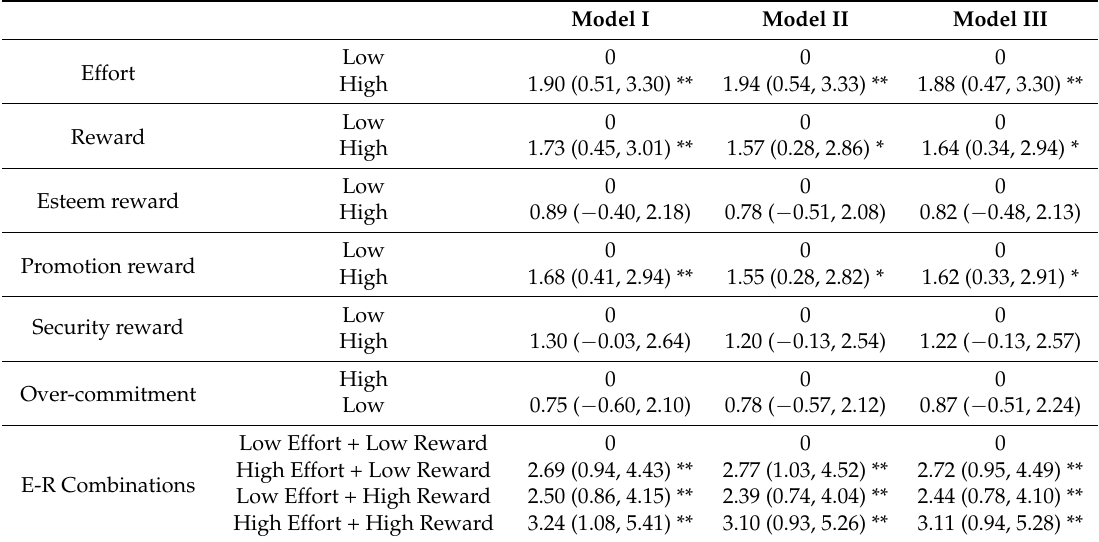
Table 2. Associations of ERI in 2006 with changes in Perceptual Speed (Symbol-Digit Test) during 2006–2012 ( n = 1031).